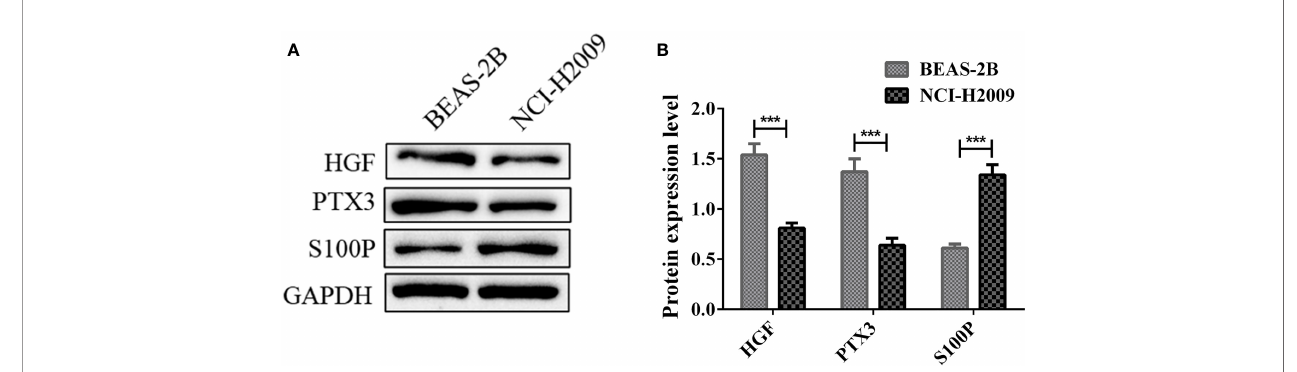
FIGURE 11 | Protein expression levels of HGF, PTX3, S100P in BEAS-2B and NCI-H2009. (A) Western blot bands representing HGF, PTX3, S100P protein expression level in BEAS-2B and NCI-H2009; (B) Protein expression level of HGF, PTX3, S100P. ***P